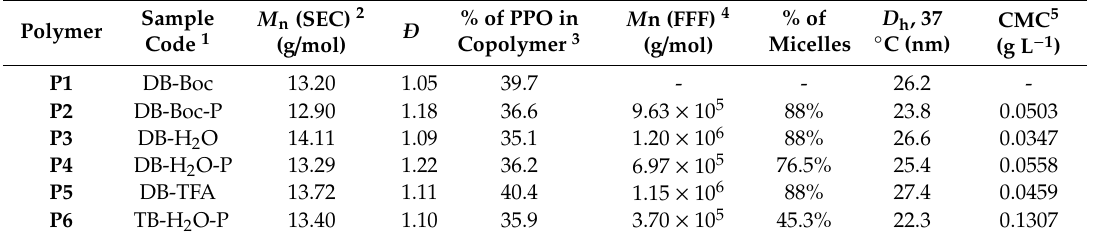
Table 2. Characterization of diblock and triblock amphiphilic polymers based on PHPMA and PPO.